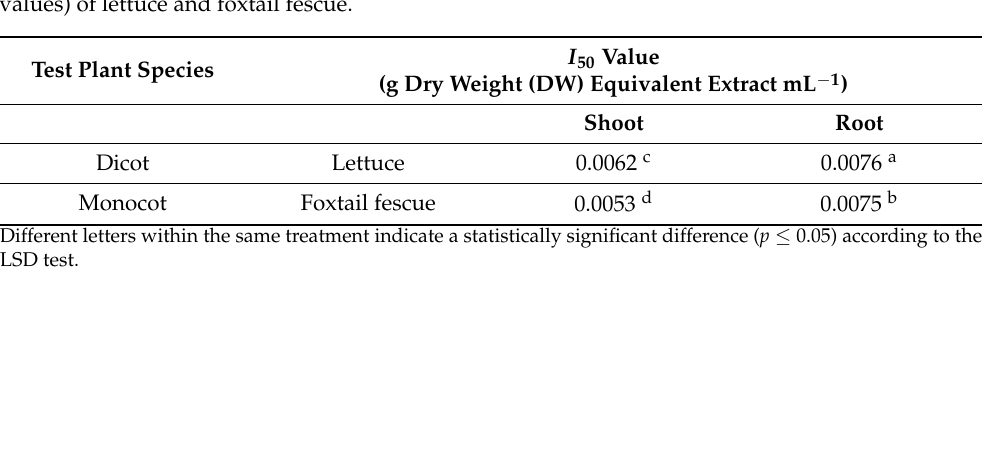
Figure 3. T. nudiflora leaf extract treatment at various doses inhibited the shoot growth of the test plants. Mean ± SE of two independent experiments repeated three times. Vertical bars illustrate the standard error of the mean. Different letters stand for differences between the control and T. nudiflora treatments (Tukey’s HSD at p ≤ 0.05). Table 1. T. nudiflora extract concentrations required for 50% shoot and root growth inhibition ( I 50 values) of lettuce and foxtail